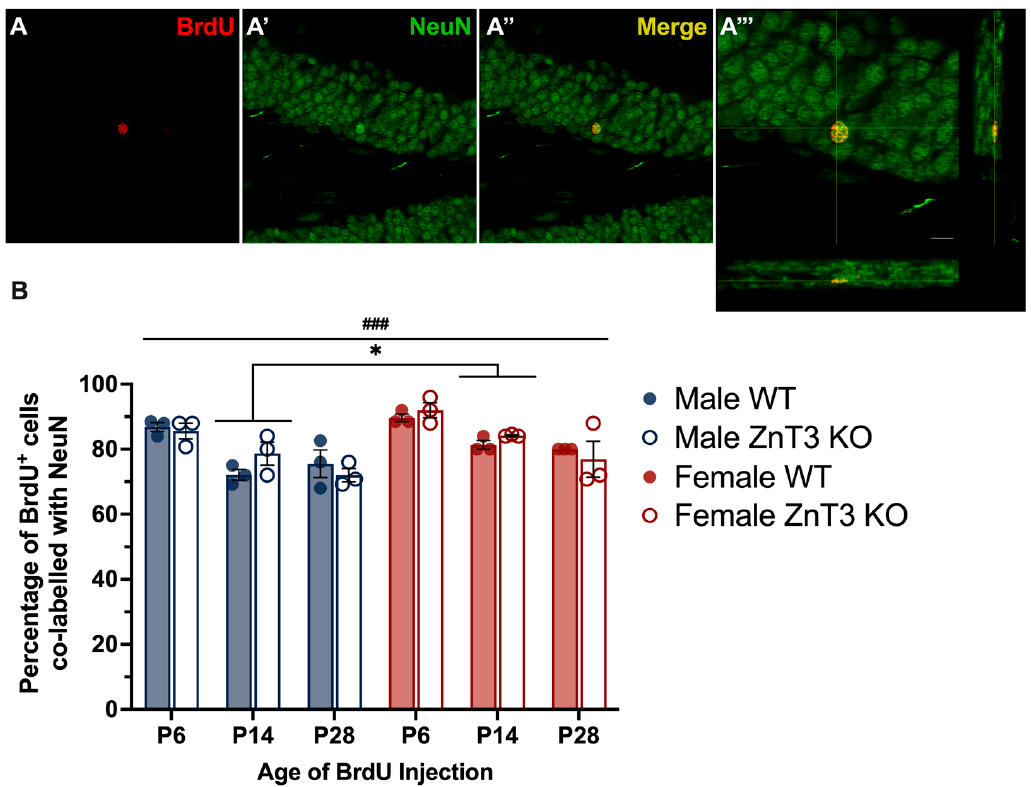
Figure 8. Neuronal phenotype of cells that survived to P60 in male and female WT and ZnT3 KO mice injected on P6, P14, and P28. BrdU was administered to male WT and ZnT3 KO mice on P6, P14, or P28 to label dividing cells. Brains were collected on P60, and a subset of brain sections was stained for BrdU and NeuN ( n = 3 per group). Representative confocal microscopic images of ( A ) BrdU- (red) and ( A’ ) NeuN-immunopositive cells (green) in the same plane. ( A’’ ) Neuronal phenotype of the cells was determined by co-localisation of BrdU and NeuN (yellow), as shown in the ( A’’’ ) representative image with an orthogonal view (BrdU in red co-labelled with NeuN in green shows as yellow). All photomicrographs were taken at 60× magnification. Scale bar = 10 µm. ( B ) While female mice had a significantly higher percentage of BrdU + cells that were co-localised with NeuN compared to male mice across all ages, this was only statistically significant for cells labelled on P14. Cells that were labelled on P6 also had significantly higher percentages of BrdU + cells that were co-localised with NeuN compared to cells labelled on P14 and P28. Error bars represent ± standard error of the mean. ### Main effect of age, p < 0.001; * indicates p <